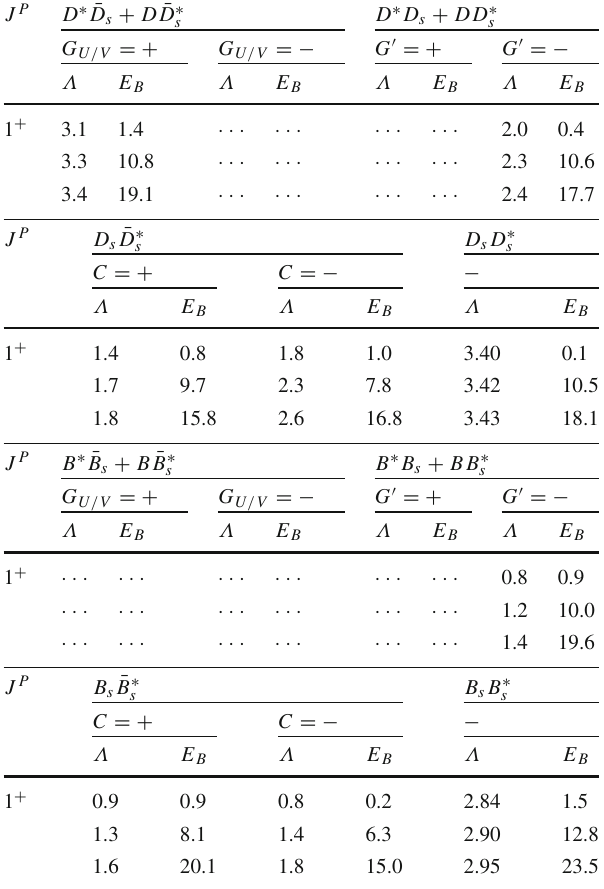
Table 3 The binding energies of the bound states from the interactions D (